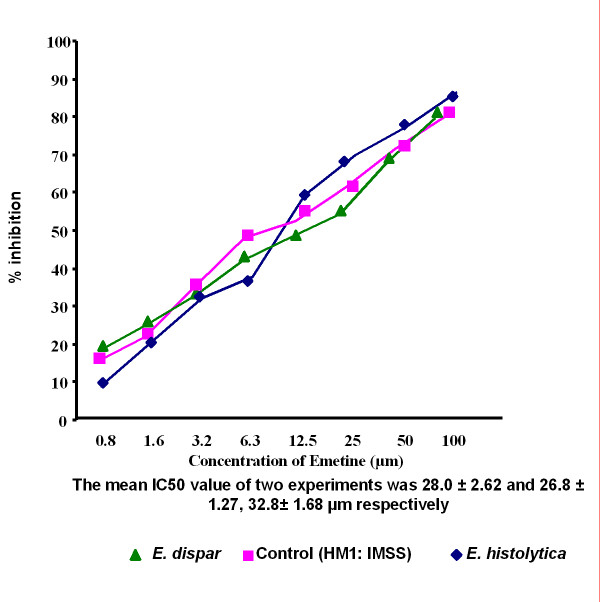
Percentage inhibition of E. histolytica (HM1: IMSS) and clinical isolates of E. histolytica and E. dispar by emetine